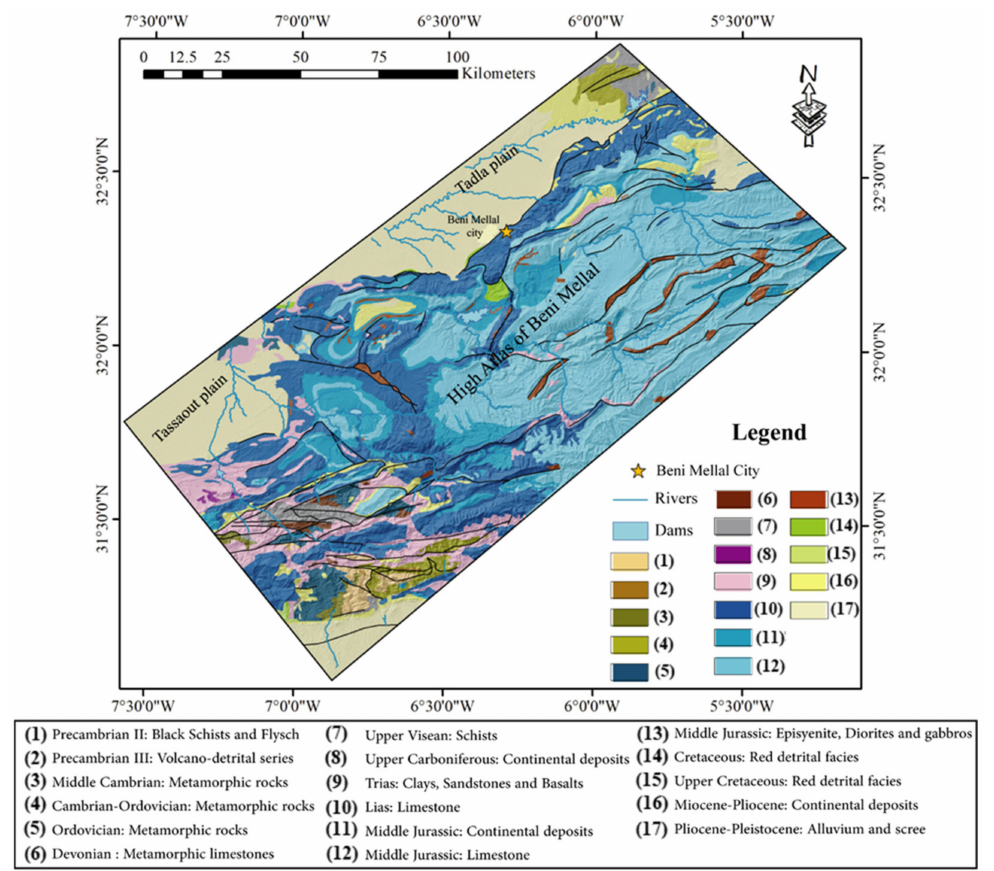
Figure 2. Geological setting of the study